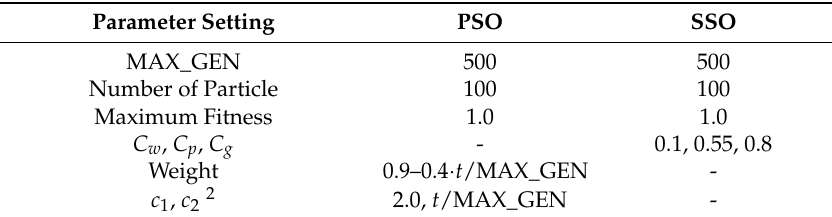
Table 2. Parameter setting for PSO and SSO algorithm 1 . Parameter Setting PSO